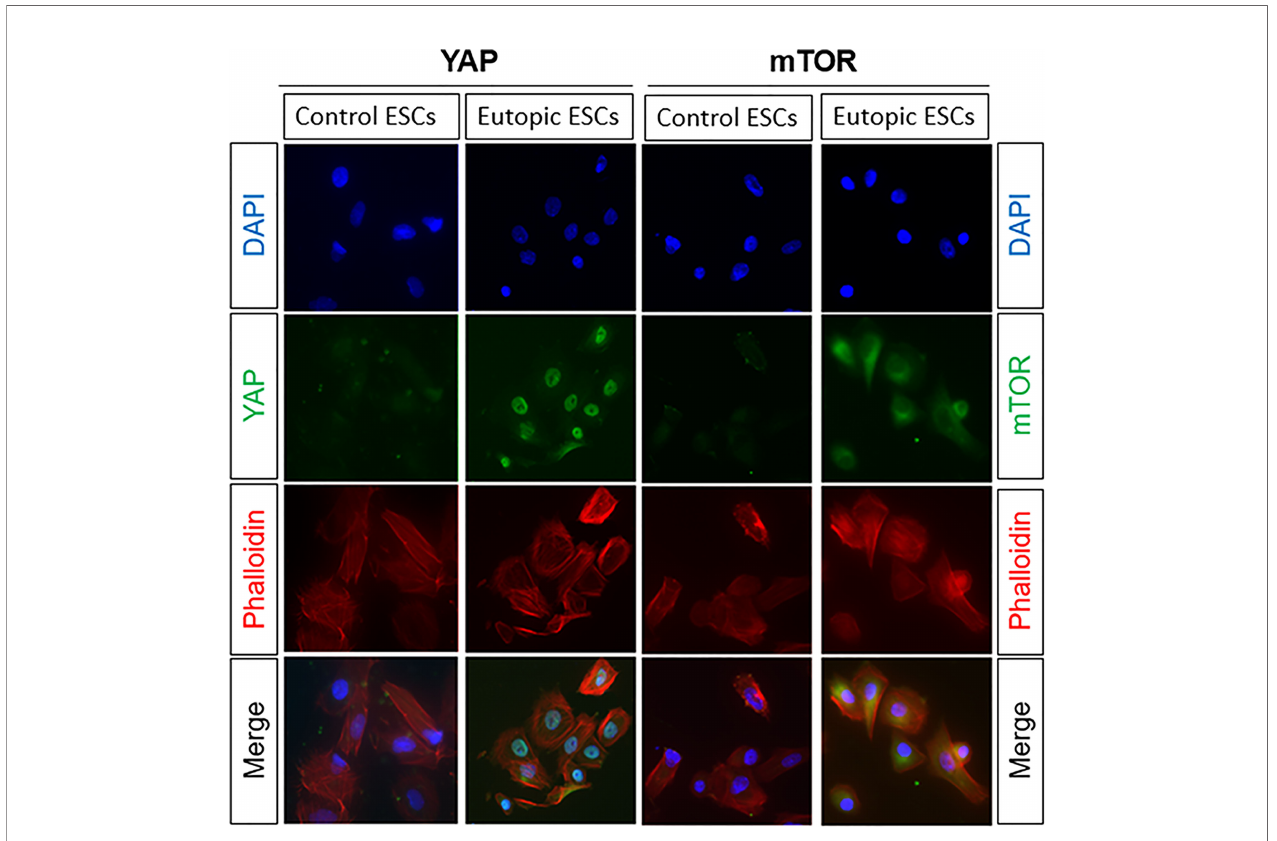
FIGURE 3 | The protein locations of YAP and mTOR in the eutopic ESCs. The results of immuno fl uorescence showed that YAP was mainly expressed in the nucleus of the eutopic ESCs and a little in the cytoplasm, whereas in the normal ESCs, YAP was mainly located in the cytoplasm and slightly expressed in the nucleus. mTOR was mainly expressed in the cytoplasm of the eutopic ESCs and a little in the nucleus, whereas mTOR was expressed in small amounts in the cytoplasm of normal ESCs, but it was hardly expressed in the